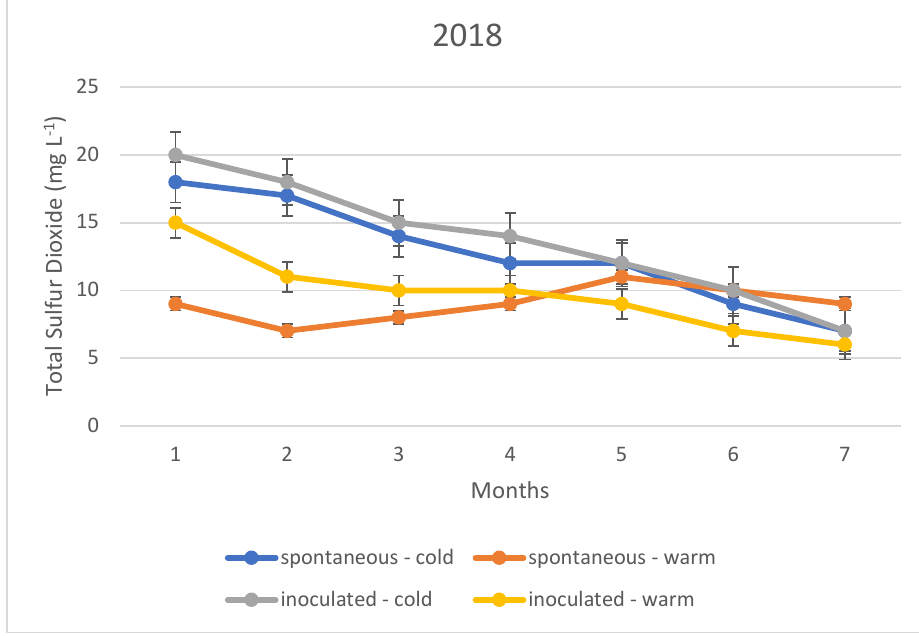
Figure 2. Total sulphur dioxide content measured during storage in 2018.